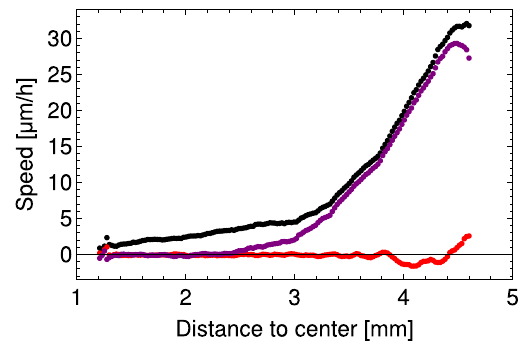
FIG. 13. Cell velocity and its components inside the tissue and saturation of the cell speed at the edge. Through PIVanalysis (see Appendix D3), the cell speed (in black) and its components (radial in purple, tangential in red) are obtained.